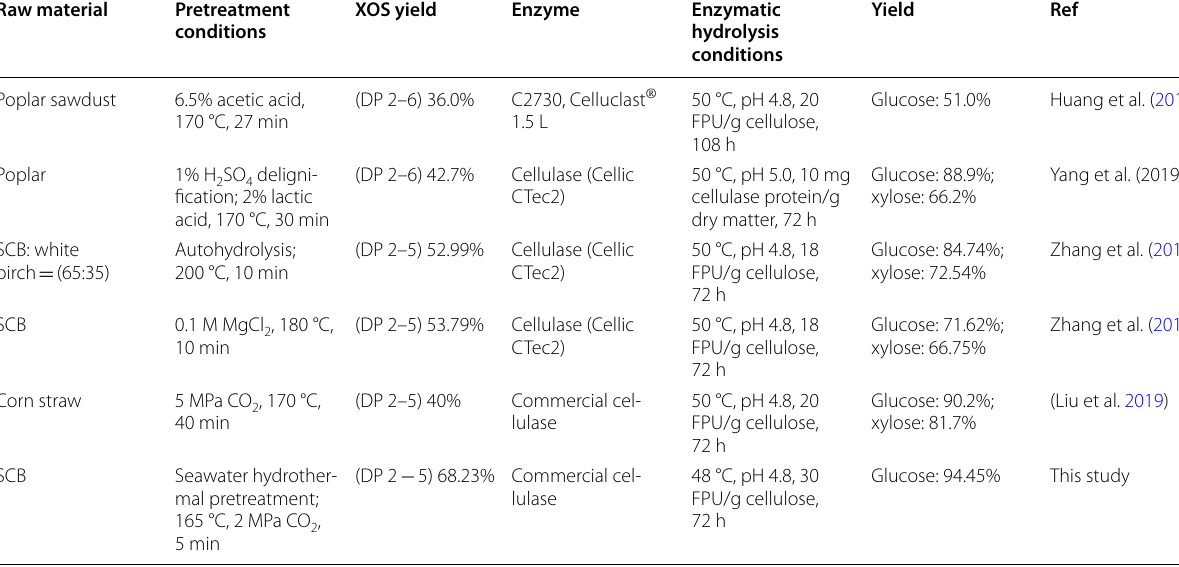
Table 5 XOS yield and enzymatic hydrolysis performance under different pretreatment strategies Raw